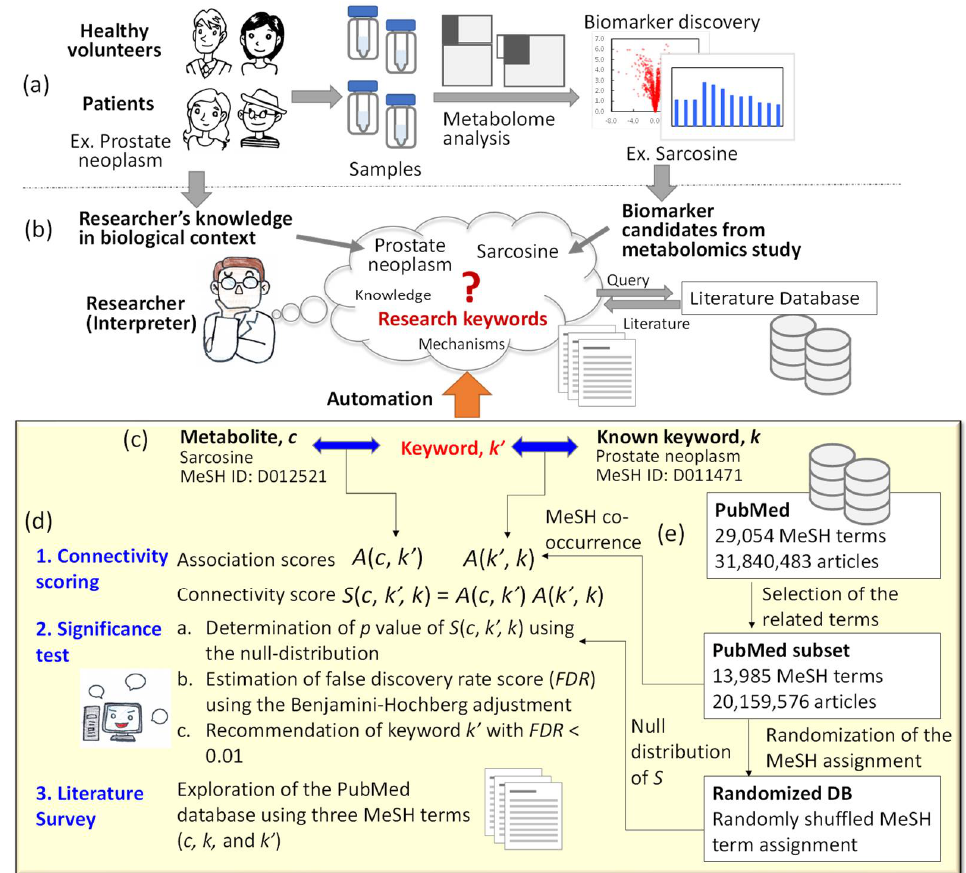
Figure 1. An automated method for finding Medical Subject Heading (MeSH) terms highlighting an association between metabolome data and the researcher’s knowledge. ( a ) A typical metabolomics research for biomarker discovery. ( b ) Tasks of a researcher to find research keywords suggesting a molecular mechanism. ( c ) Relationships among MeSH terms of a metabolite c obtained via metabolome analysis, a keywords k ′, and the researcher’s known keyword k . ( d ) Novel method for key-